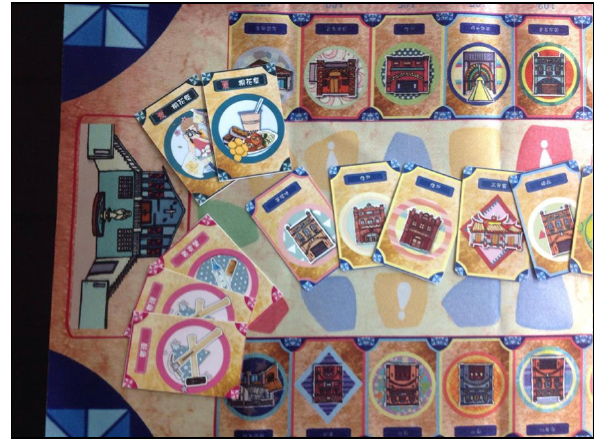
Figure 1. Game board and cards of “3D AR for Hukou Old Street ”